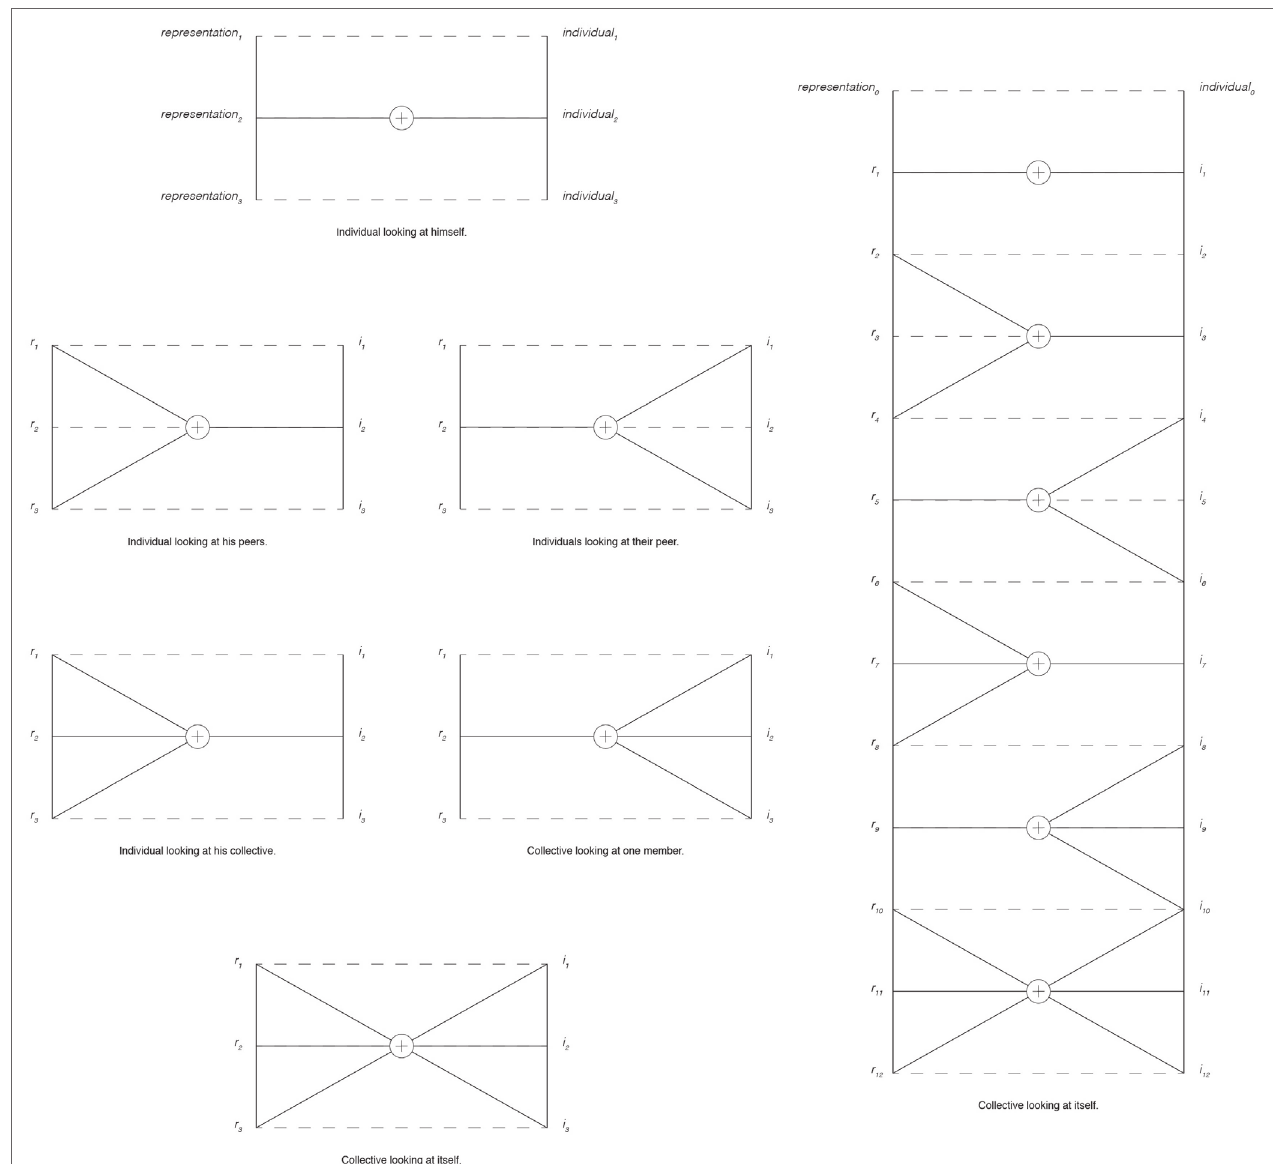
FigUre 7 | Different configurations of reading. On the left, a set of configurations schematizes the relation between the reader and its image, covering the actualization of the screen and the poster. On the right, we simulate a potential interaction of a collective representing itself, which corresponds to the carpet